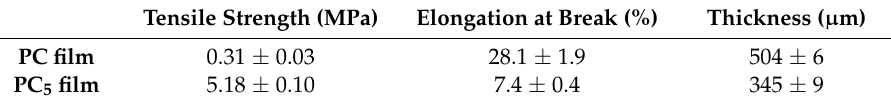
Table 2. Tensile testing results of the PC and PC 5 films.